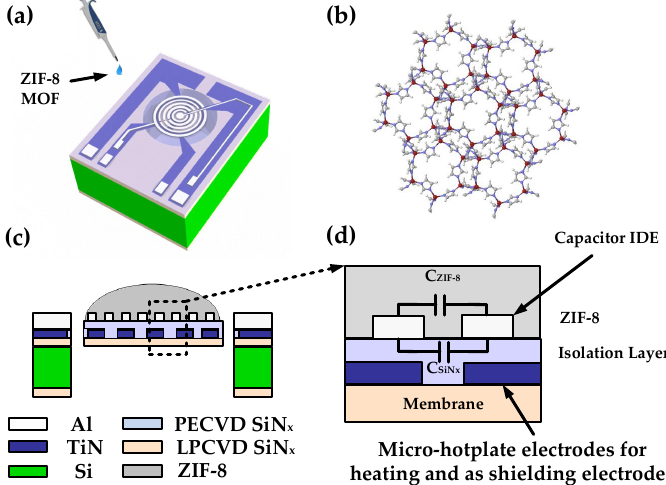
Figure 1. Device concept of ZIF-8 MOF-coated micro-electromechanical system (MEMS) interdigitated electrodes (IDE) capacitor with integrated microhotplate: ( a ) Illustration of ZIF-8 MOF drop-casted on the final device. ( b ) 3D view of the crystal structure of ZIF-8 MOF with Zn, N, C, and H described by red, purple, grey and white spheres respectively [27]. ( c ) Cross section of the device with deposited ZIF-8 MOF. ( d ) Description of equivalent electrical circuit of the IDE capacitor with microhotplate electrodes. PECVD: Plasma enhanced chemical vapor deposition; LPCVD: Low pressure chemical vapor